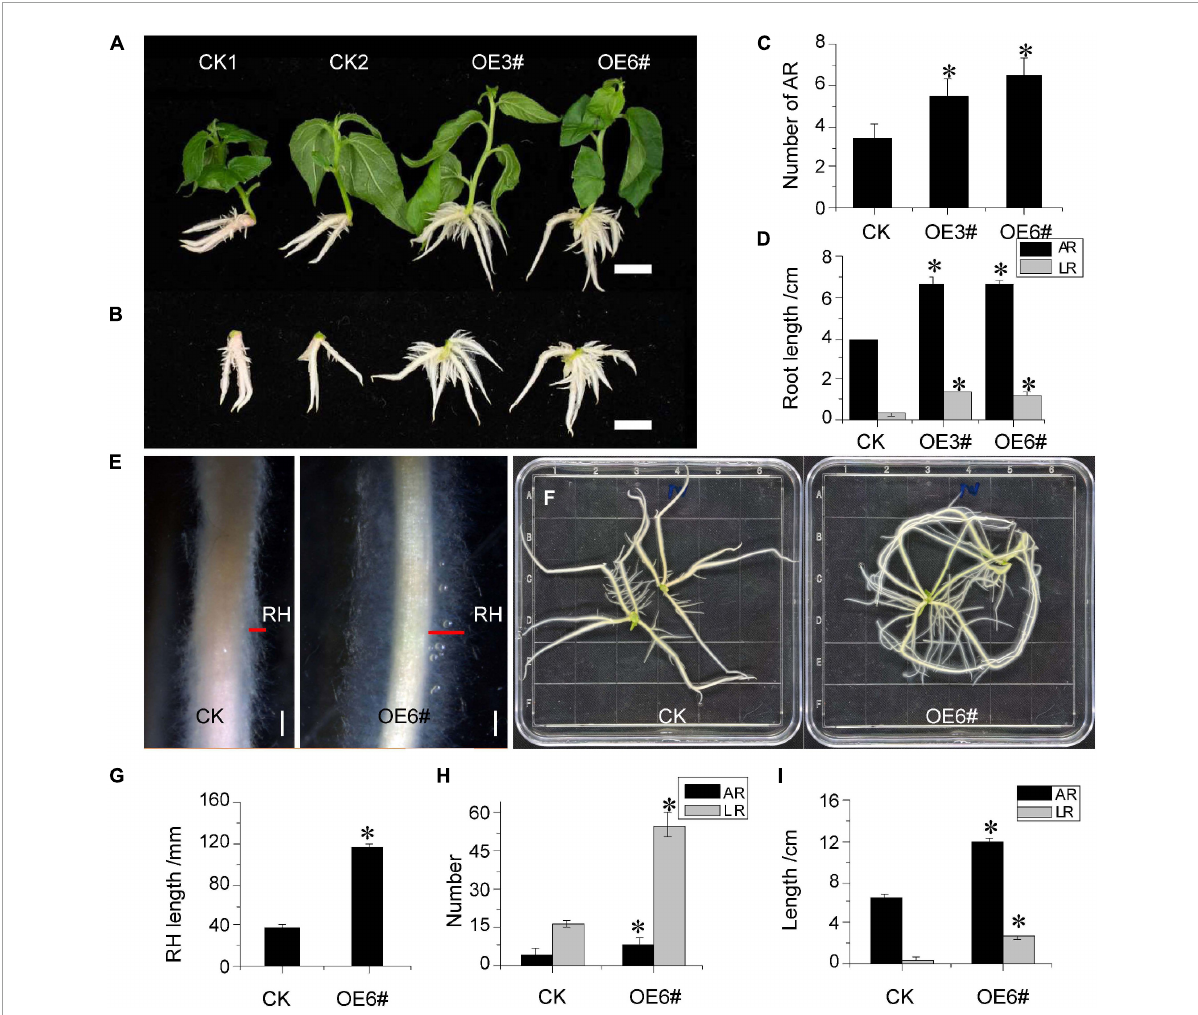
FIGURE6 Overexpression of JrWOX11 regulated root system architecture. (A) Comparison of AR number between CK and OE 3# and OE 3# 6# (2 weeks old). (B) The vertical view of ARs of CK and overexpressing lines 3# and 6# (2 weeks old). Bar = 1 cm. (C,D) Average AR length, AR number, and LR length in Control and the overexpressing lines (2 weeks old). (E) Root hairs of 4-week-old seedlings. Bars = 2 mm. (F) Root system phenotypes of the control group (CK) and WOX11 transgenic plants (OE#6) (4 weeks old). Bar = 1 cm. (G–I) Length of RH, average root length, and root number in Control and the overexpressing line (OE#6) (4 weeks old). Asterisk indicates a significant difference ( ∗ P < 0.05) between transgenic lines and WT